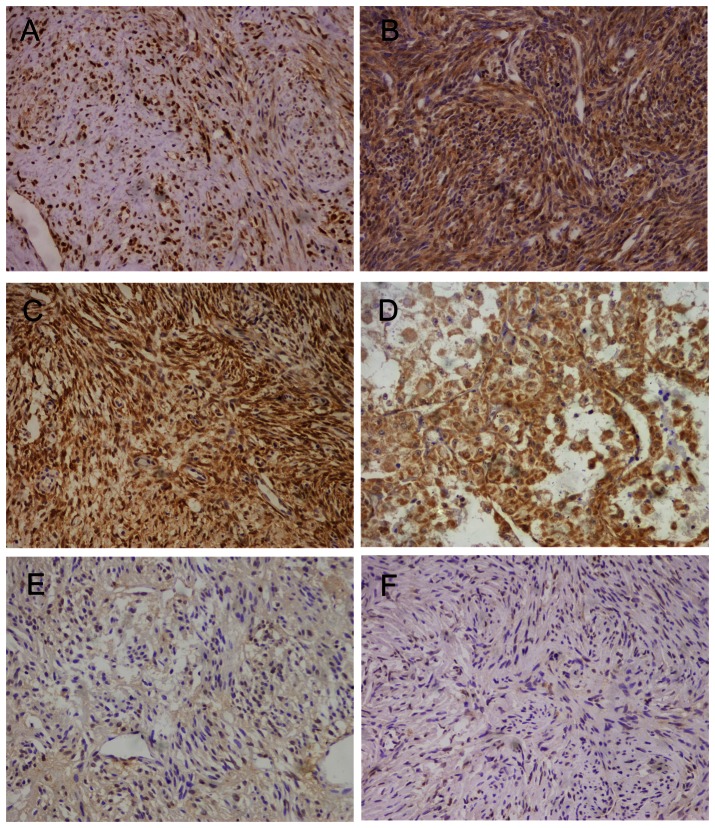
Immunohistochemical analysis of PTEN in STS.Positive immunohistochemical staining in (A) leyomiosarcoma, (B) Synovial sarcoma, (C) Dermatofbrosarcoma protuberans,and (D) Alveolar rhabdomyosarcoma. Negative immunohistochemical staining in (E) high-grade leyomiosarcoma and (F) Dermatofbrosarcoma protuberans. All Original magnification×20.